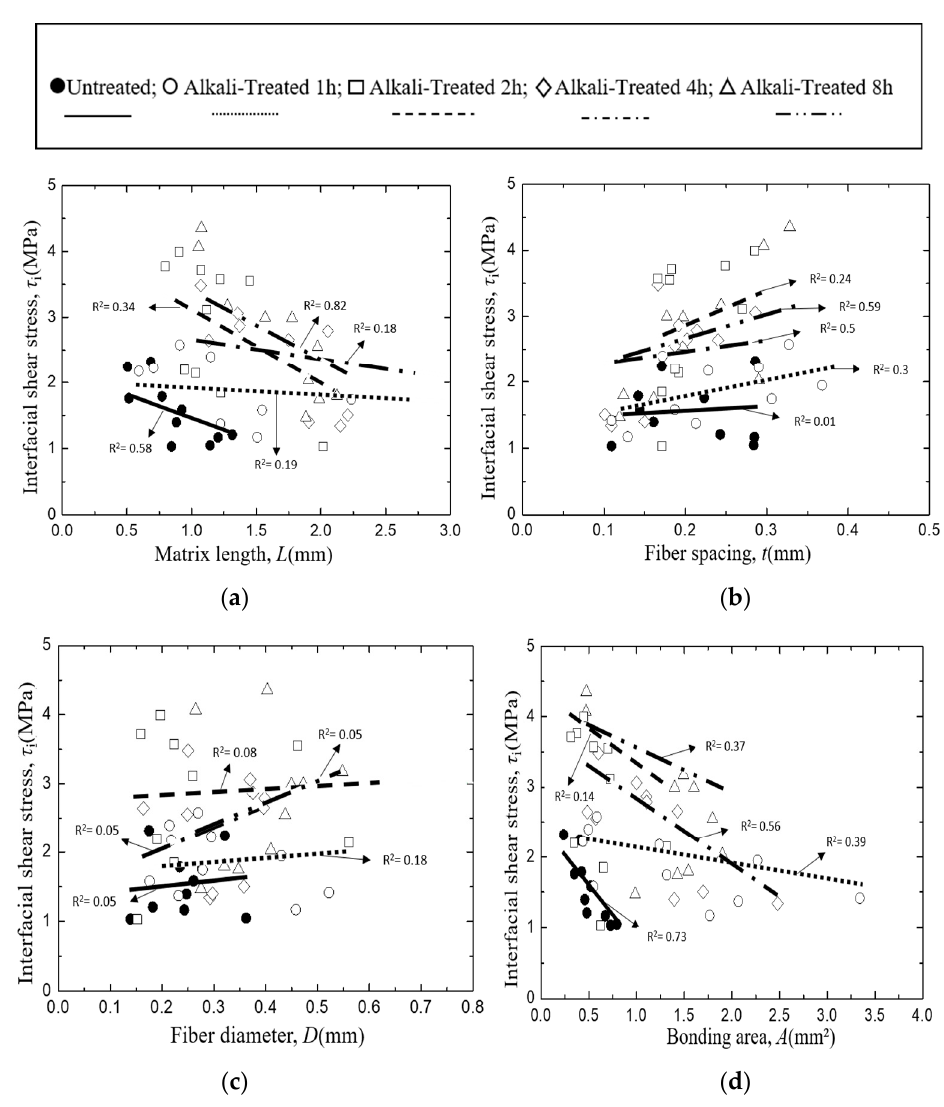
Figure 11. Interfacial shear strength of Typha spp. /PLLA, where: ( a ) Matrix length, ( b ) Fiber spacing, ( c ) Fiber Diameter, ( d ) Bonding area.